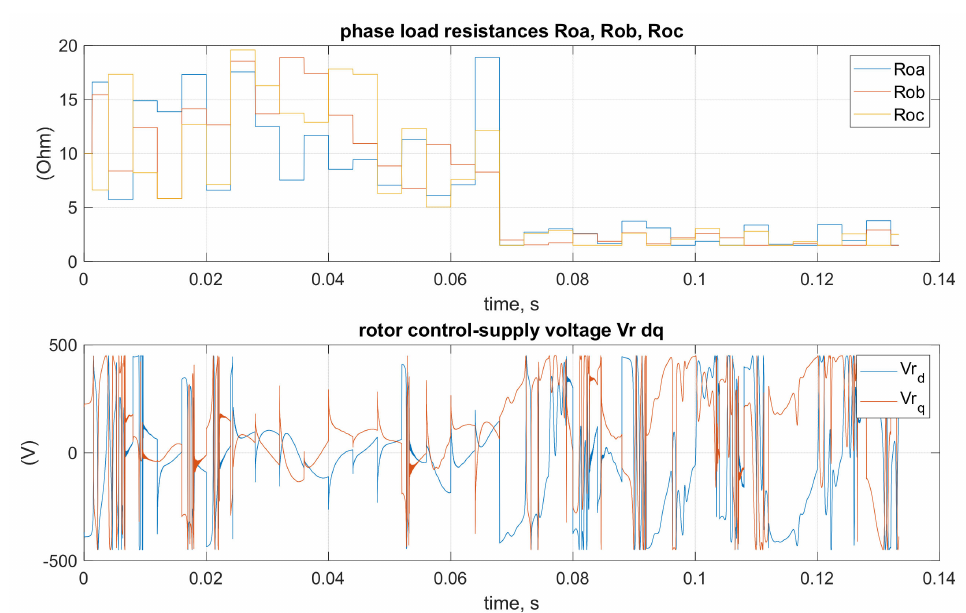
Figure 16. The rotor control voltage V r in the dq coordinate system against the changes in resistance of the load phases in the islanded grid with the voltage V r limit V f _ m = 450 V.